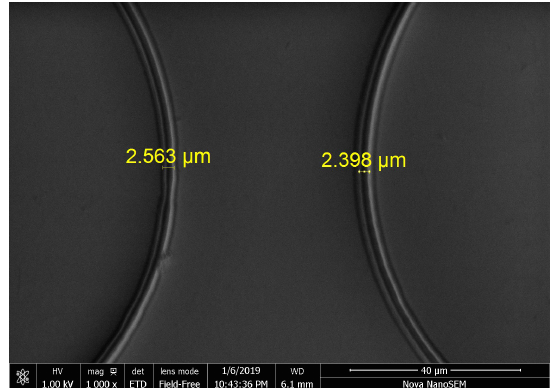
Figure 15. The SEM image of the fabricated feature